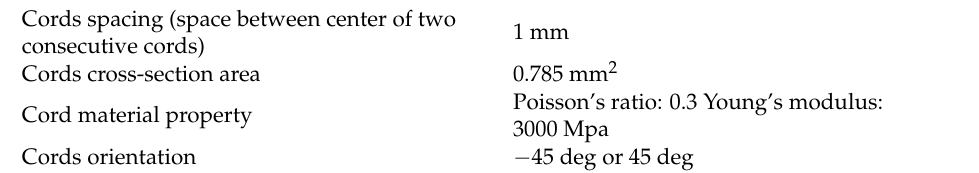
Figure 3. The rebar element. ( a ) A two-dimensional element is built between two solid elements, and a rebar element exits on the two-dimensional element. ( b ) The reinforcement composite layers meshed by membrane elements in which the rebar was built. Table 1. The geometric properties and material properties needed to define rebar elements in this paper.